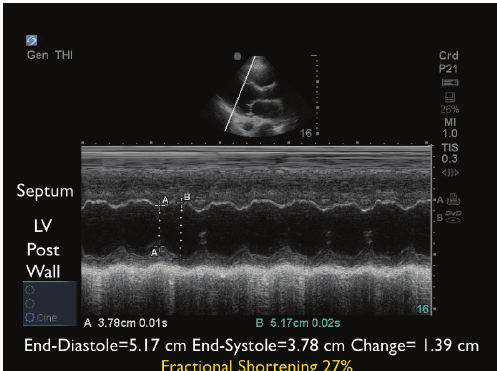
Figure 9: M-mode tracing demonstrating poor contractility. LV: left